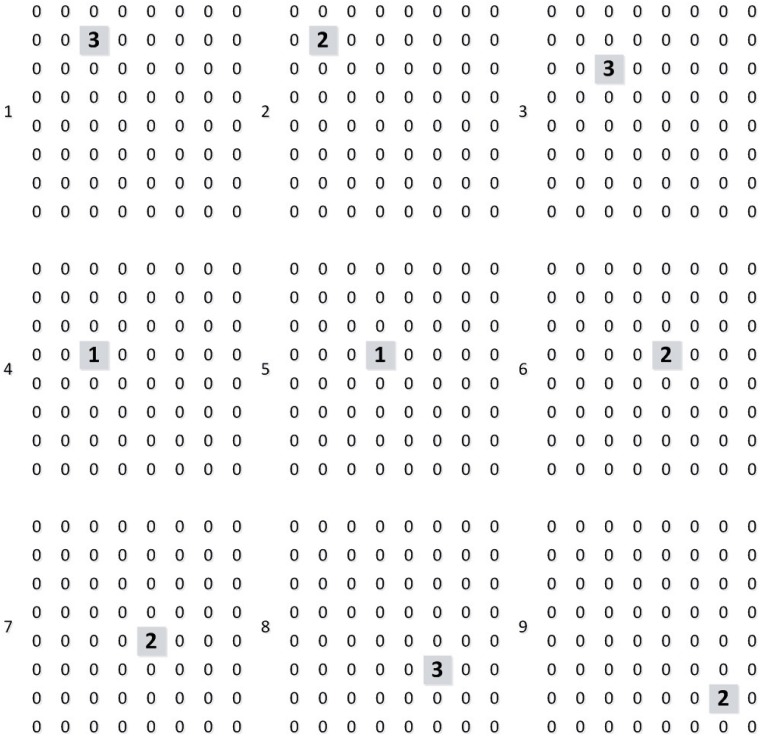
Output of distance.